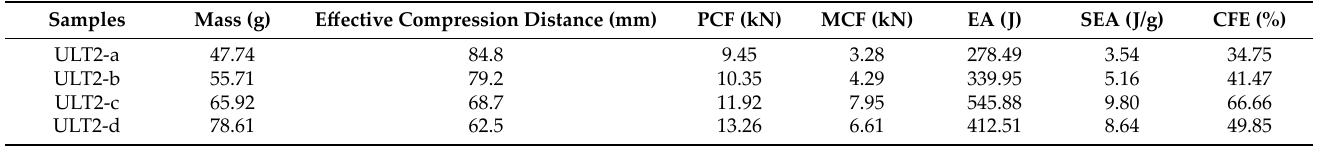
Table 6. Energy absorption parameters of the ULT2 model with different density configurations.